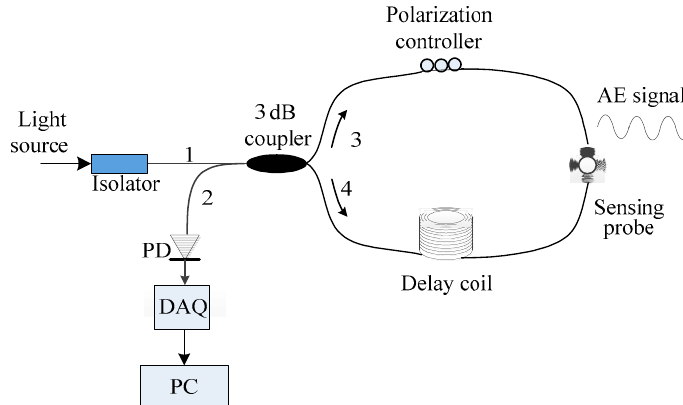
Figure 1. Principle of the optical fiber Sagnac acoustic emission (AE) sensor.